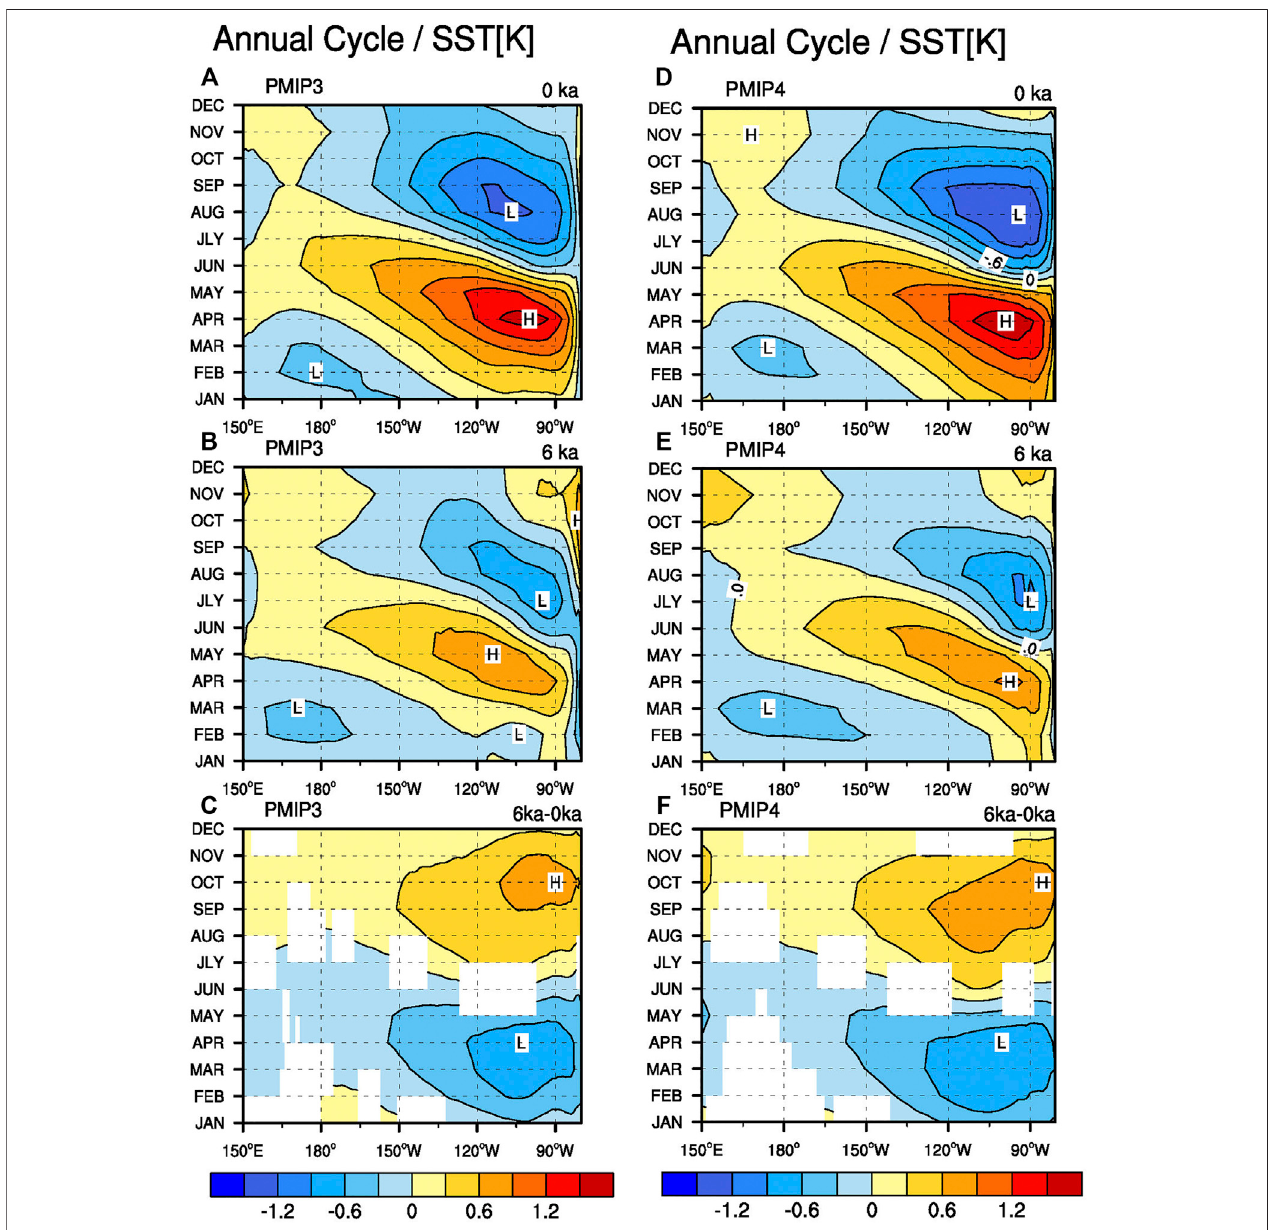
FIGURE 4 | Plots for MME of SST annual cycle over the equatorial Paci fi c (averaged between 5 o S and 5 o N) derived from PMIP3 (left column) and PMIP4 (right column)models. (A) and (D) arePIsimulations; (B) and (E) areMHsimulations;and (C) and (F) aretheirdifferences(MHminusPI).LettersHandLrepresentthepositive and negative centers, respectively. Shading in (C) and (F) indicate the difference between MH and PI is signi fi cant at the 95% level by Student ’ s t -test.